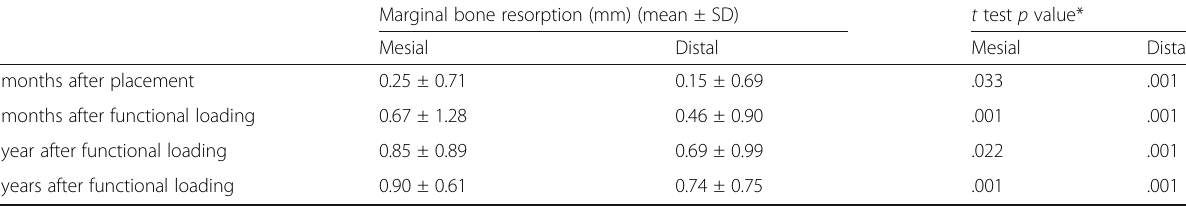
Table 6 Marginal bone loss (MBL) evaluation on the mesial and distal sides of the implant according to the observation period